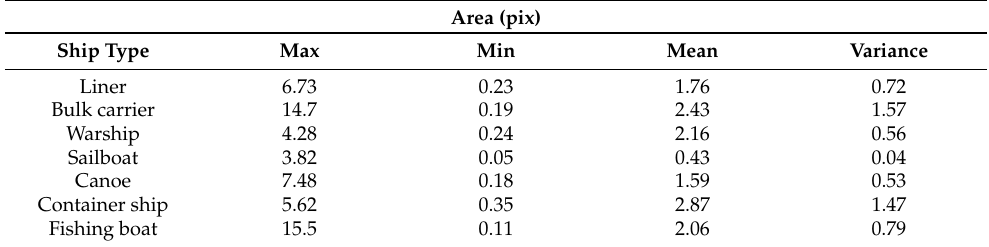
Table 4. The aspect ratio distribution of the target. The max, min, mean and variance, respectively, represent the maximum, minimum, mean and variance of the target aspect ratio in one class of